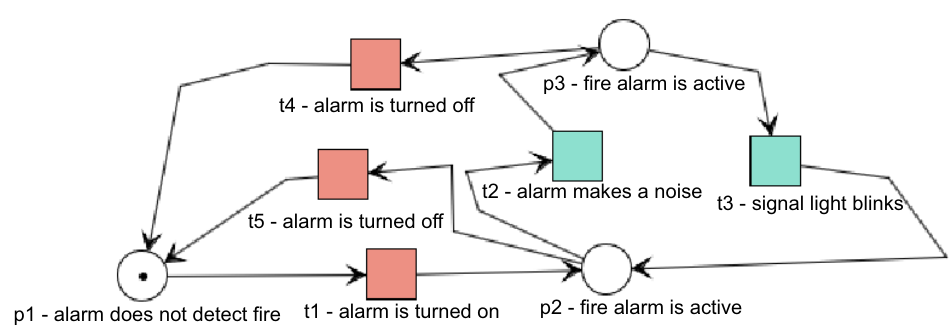
Figure 8. Petri Net for fire alarm (initial marking).